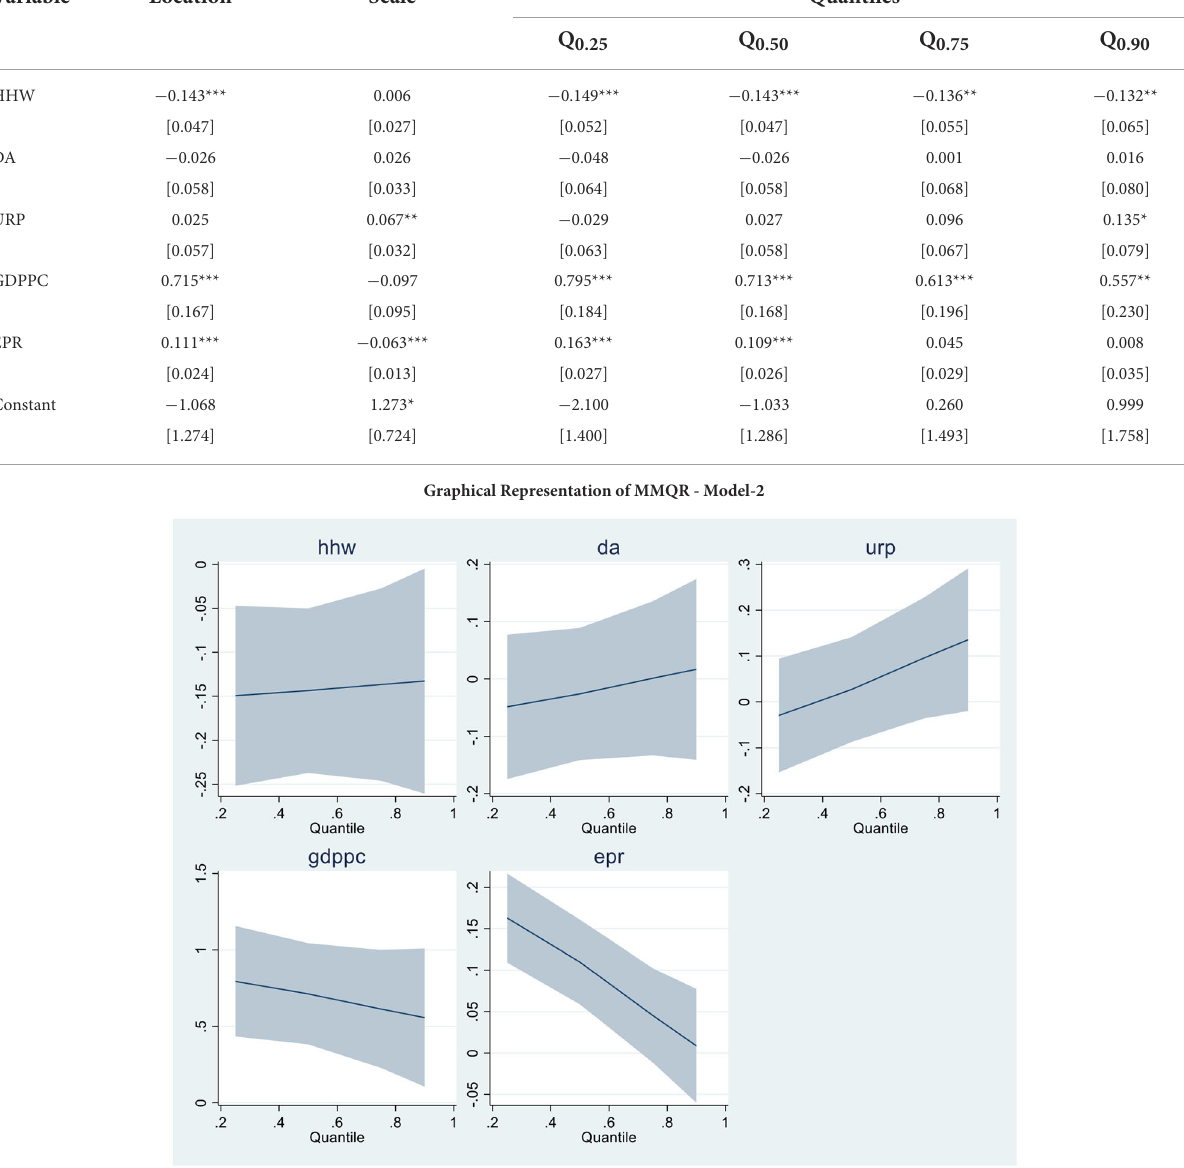
TABLE 7 Estimates of quantile regression–MMQR